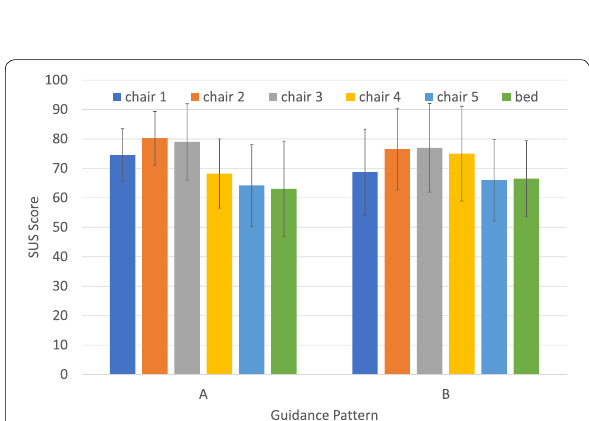
Fig. 12 SUS scores. Blue, orange, grey, yellow, aqua, and green lines are average SUS scores for chair 1, 2, 3, 4, 5, and bed, respectively. The black lines show the standard